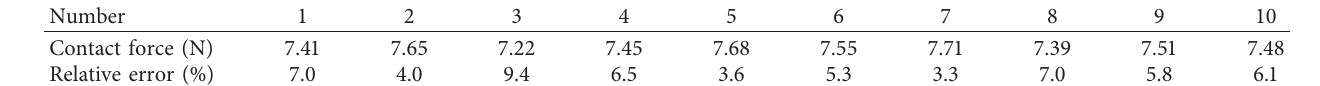
Table 2: Contact force data in improved impedance